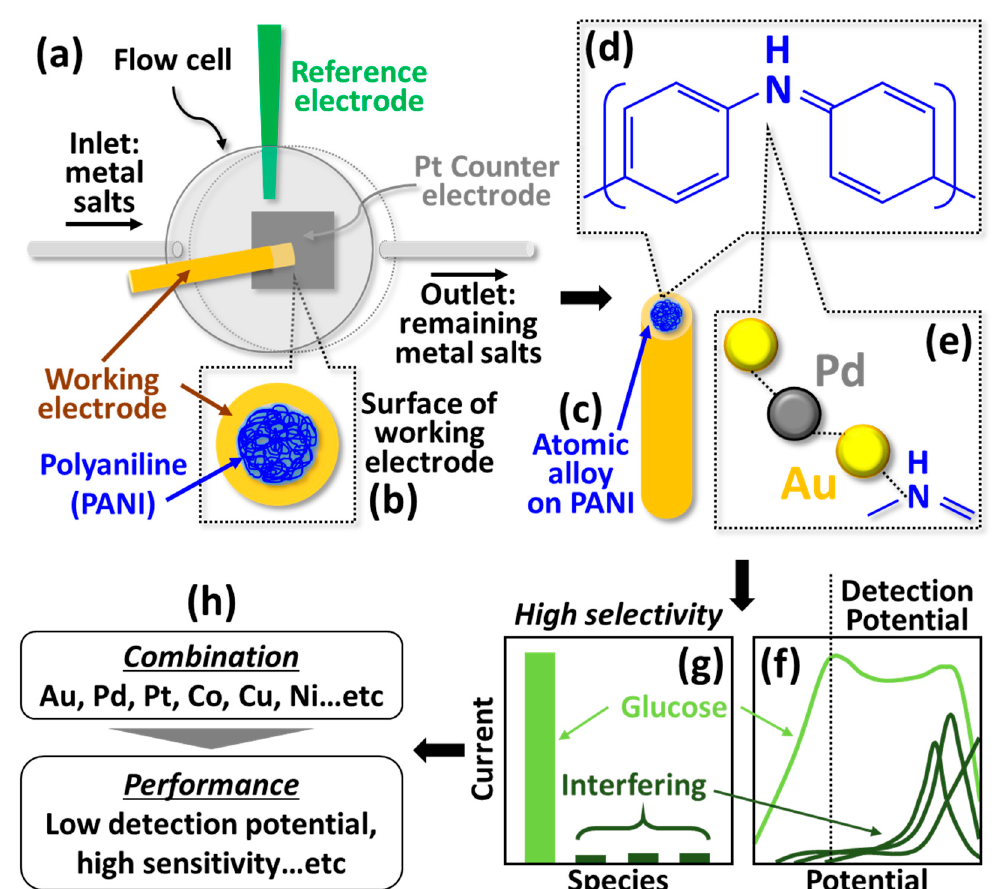
Figure 14. ( a ) The flow cell system, which is connected to the flow controller and the potentiostat, is for the atomic deposition of metal or alloy. ( b ) The glassy carbon electrode (GCE) (yellow color) is inserted into the front side of the flow cell and the PANI (network structure and blue color) is deposited on the surface of GCE prior to the atomic deposition of metal or alloy. ( c ) After the atomic deposition of metal or alloy on the PANI/GCE. ( d ) Illustration of the metal or alloy around the functional group of PANI. ( e ) Close-up image of the metal or alloy around the functional group of PANI. (Au (golden color) and Pd (gray color) are used as an example) ( f ) LSV curves of the electro-oxidation of glucose (light green color) and interfering molecules (dark green color), such as AA, DA, and UA. ( g ) Current responses from the glucose and the interfering molecules. ( h ) The choice of various elements and the possible outcomes from the different integration of chemical composition and different configurations of the atomic clusters.